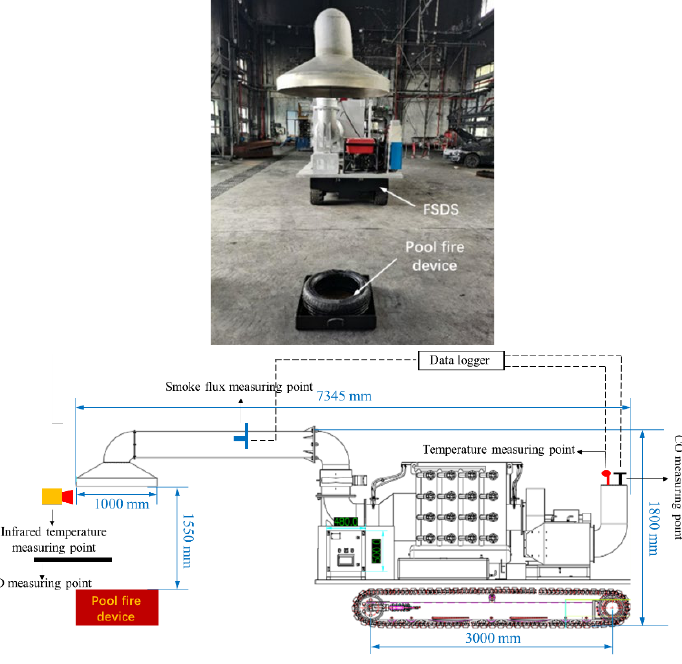
Figure 4. Designing drawing and physical drawing of the experiment setup.